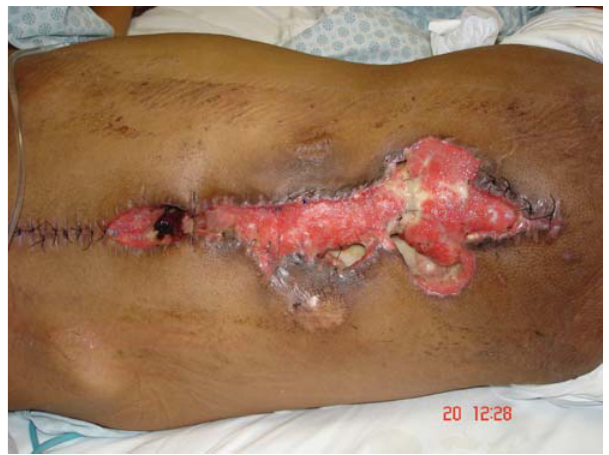
flap, the wound was completely covered and filled, and